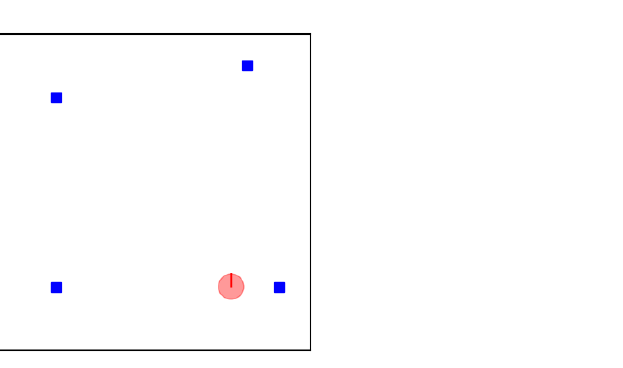
Figure 1. Simulation environment. The red circle represents the 2D robot position, the red line within the circle represents the robot’s heading, the blue rectangles represent the landmarks that are detected by the